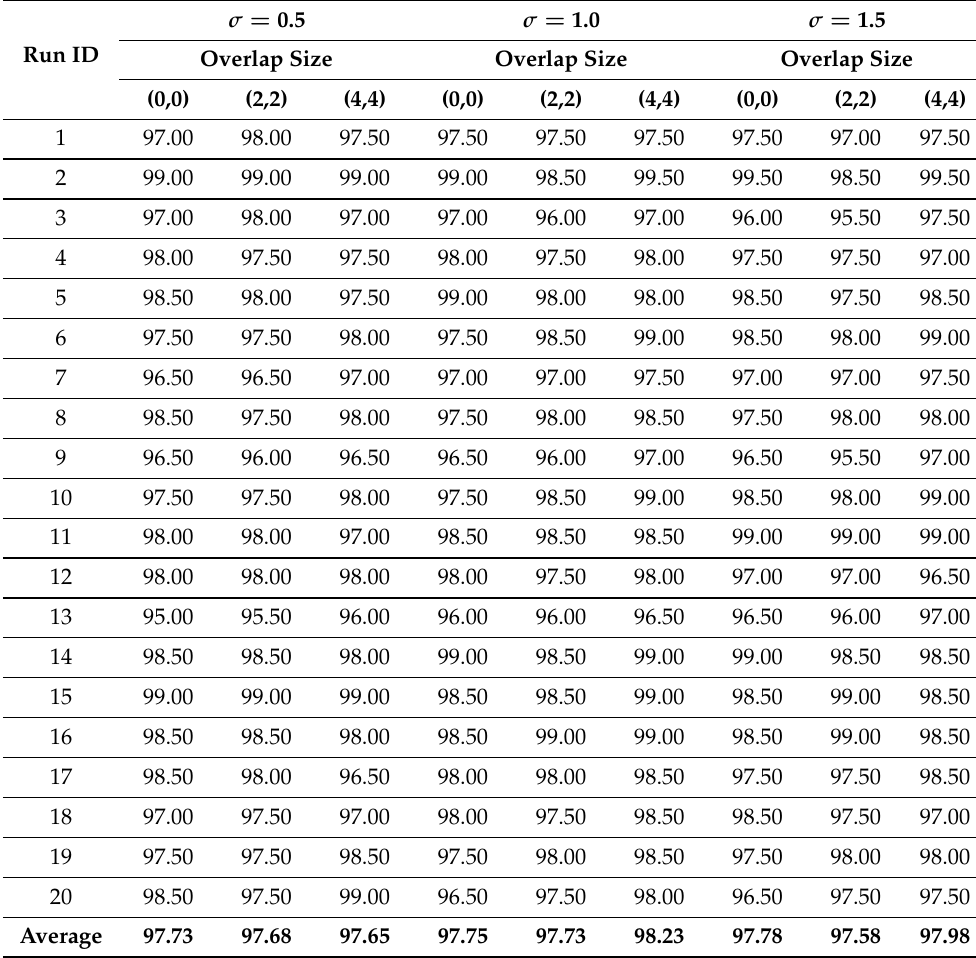
Table A1. The results of the runs for noise-free environment using different values of σ . σ = Run ID